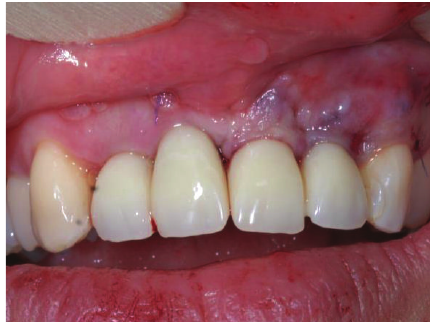
Figure 18: Image depicting the final restorations after delivery.